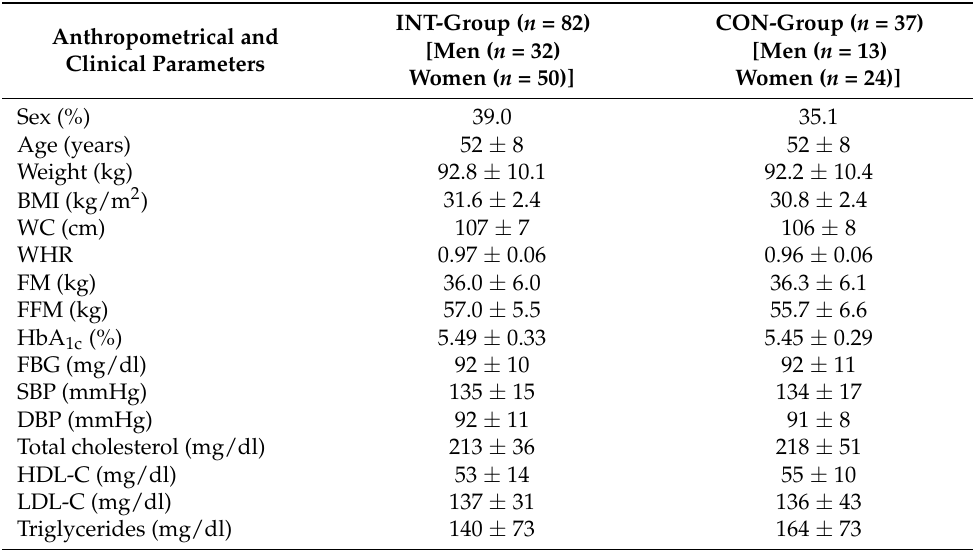
Table 1. Baseline characteristics of participants with correctly filled out dietary records for INT and CON stratified by sex.